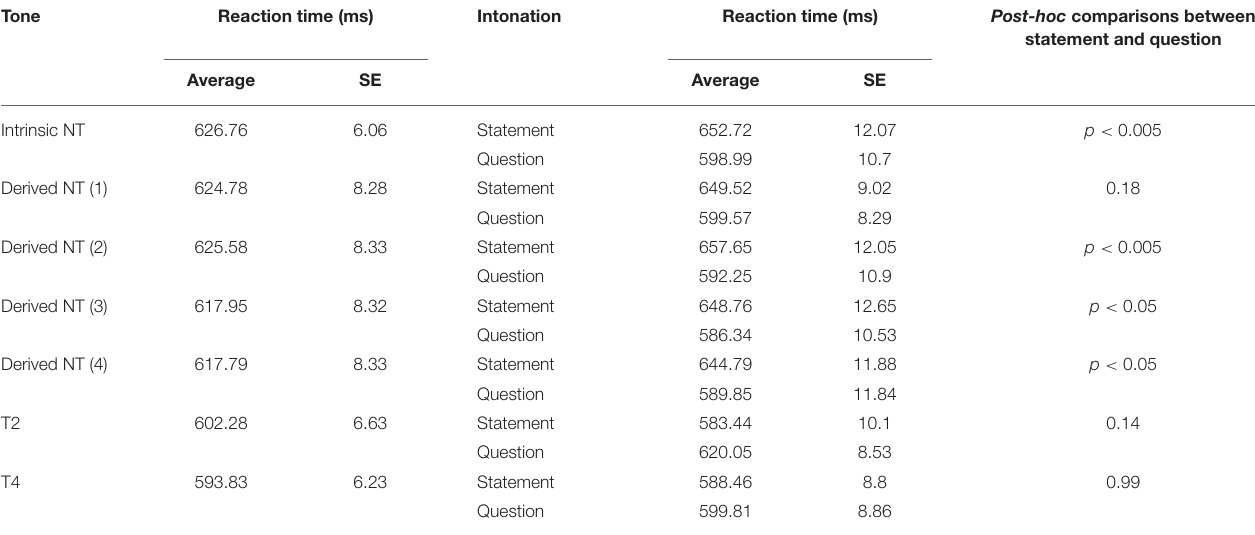
TABLE 5 | Reaction time by tone and